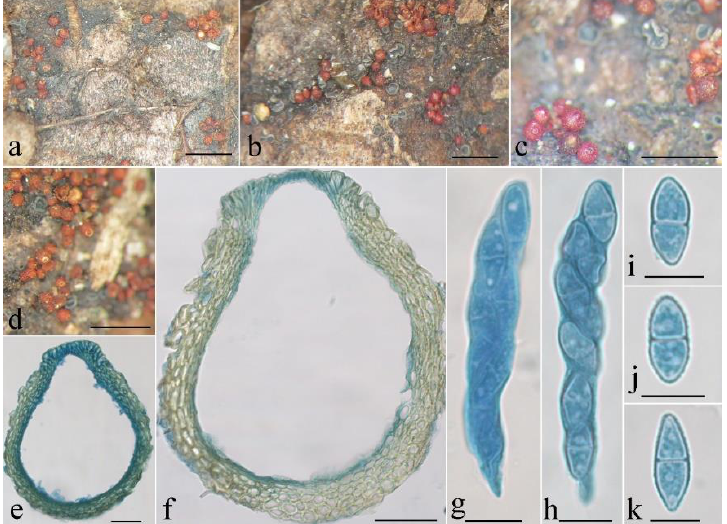
Figure 8. Macroscopic and microscopic morphology of Thelonectria globulosa (HMAS 255835). ( a – d ) Ascomata on natural substratum; ( e , f ) median section of perithecium in lactophenol cotton blue; ( g , h ) asci with ascospores in lactophenol cotton blue; ( i – k ) ascospore in lactophenol cotton blue. Bars: ( a – d ) = 1 mm; ( e , f ) = 50 μm; ( g – k ) = 10 μm.